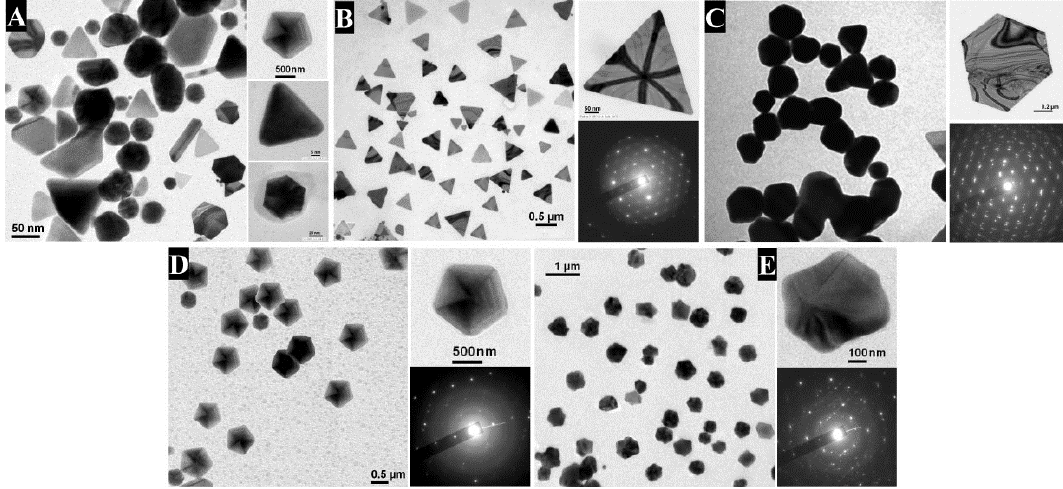
Figure 1. TEM images of Au NPs synthesized by mixing the cell-free aqueous extract of the fungus Rhizopus oryzae , obtained by tuning the experimental parameters: the amount of HAuCl 4 , the pH and the reaction time. ( A ) Mixed nanoplates (triangle, hexagon, pentagon, star, etc.). Right-hand images display individual nanoplates. Scale bars, clockwise from left are 50, 500, 5 and 20 nm. ( B ) Triangular nanoplates. Scale bars, clockwise from left are 500 and 50 nm. ( C ) Hexagonal nanoplates. No scale bars were given in the original publication except for 200 nm for the top right figure. ( D ) Pentagonal nanoplates. All scale bars are 500 nm. ( E ) Star-shaped nanoplates. Scale bars clockwise from left are 1 µm and 100 nm. For B , C , D and E , the upper picture of each right-hand image corresponds to the high-resolution single-crystalline nanoplates, and the lower image to their corresponding selected area electron diffraction (SAED) patterns, respectively. Reproduced from Reference [36] with permission from Wiley.